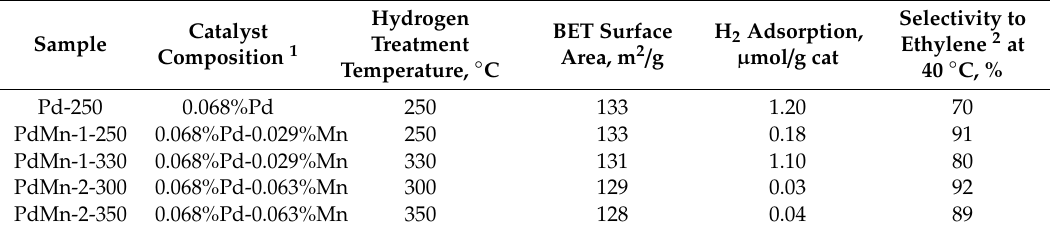
Table 1. Physicochemical data of alumina supported catalysts.